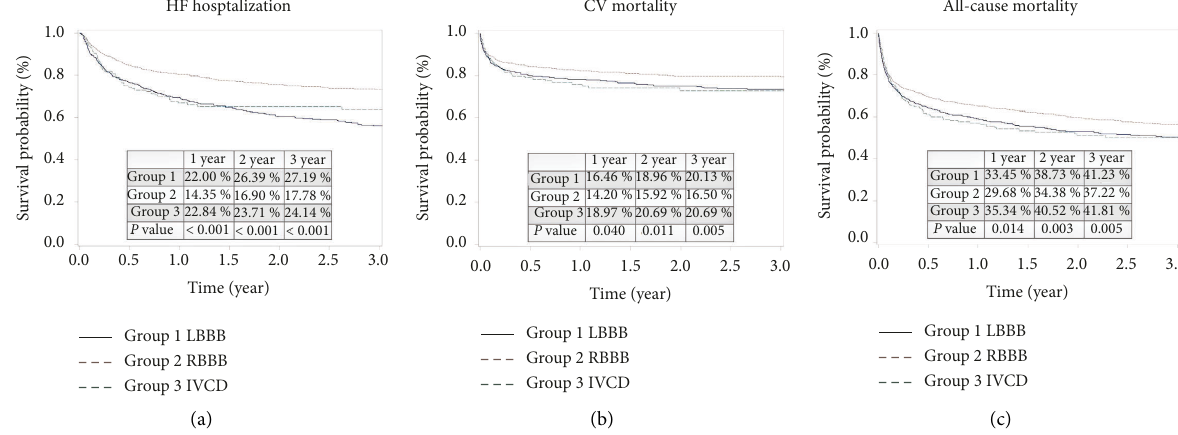
Figure 2: Kaplan–Meier curve analysis for heart failure (HF) hospitalization, cardiovascular (CV) mortality, and all-cause mortality among the patients with left bundle branch block (LBBB), right bundle branch block (RBBB), and nonspecific intraventricular conduction delay (NICD) after propensity score matching during the 3-year follow-up period. (a): Between three groups, highest incidence of HF hos- pitalization is noted in patients with LBBB after propensity score matching (LBBB vs. RBBB vs. NICD; 27.91% vs. 17.78% vs. 24.14%; p < 0 . 001). (b): Between three groups, lowest incidence of CV mortality is noted in patients with RBBB after propensity score matching (LBBB vs. RBBB vs. NICD; 20.13% vs. 16.50% vs. 20.69%; p � 0 . 005). (c): Between three groups, lowest incidence of all-cause mortality is noted in the patients with RBBB after propensity score matching (LBBB vs. RBBB vs. NICD; 41.23% vs. 37.22% vs. 41.81%; p � 0 . 005).